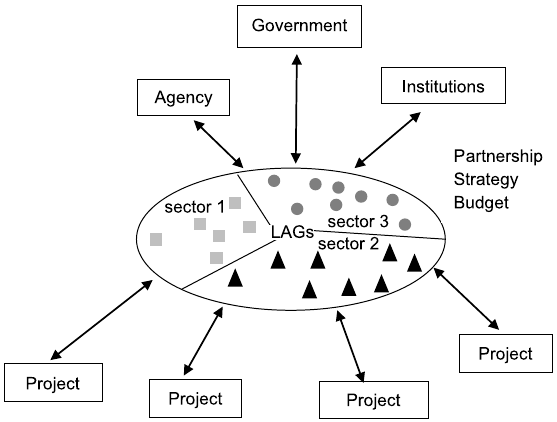
Fig. 1. Model of the LEADER type of approach.